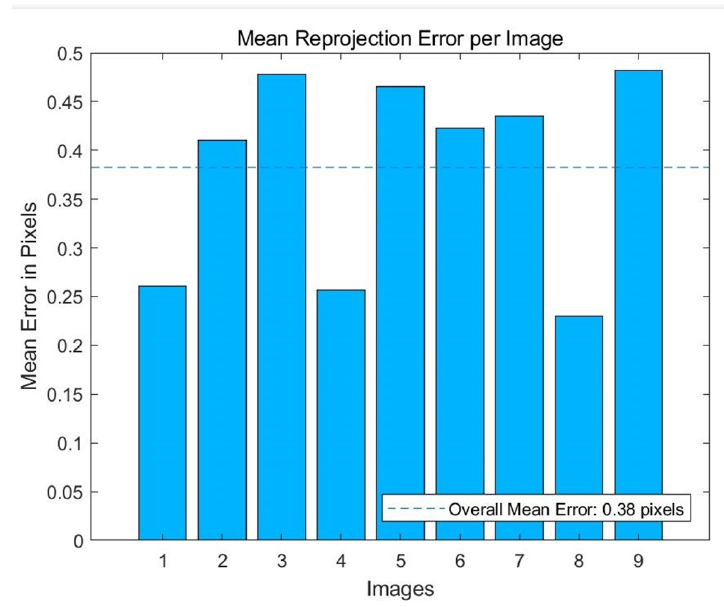
Figure 5. Mean reprojection error of nine images.